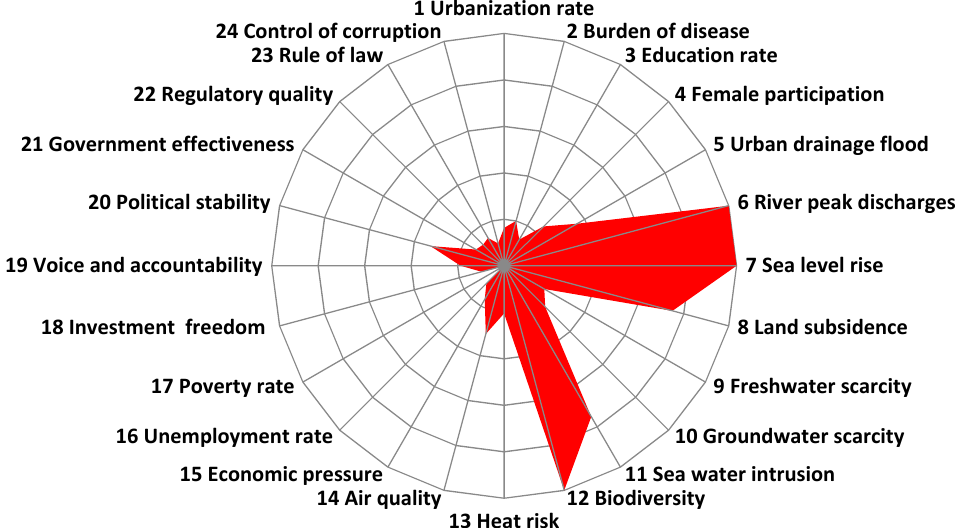
Figure 2. Trends and Pressures Framework of Amsterdam (2020) assessed according to [14].